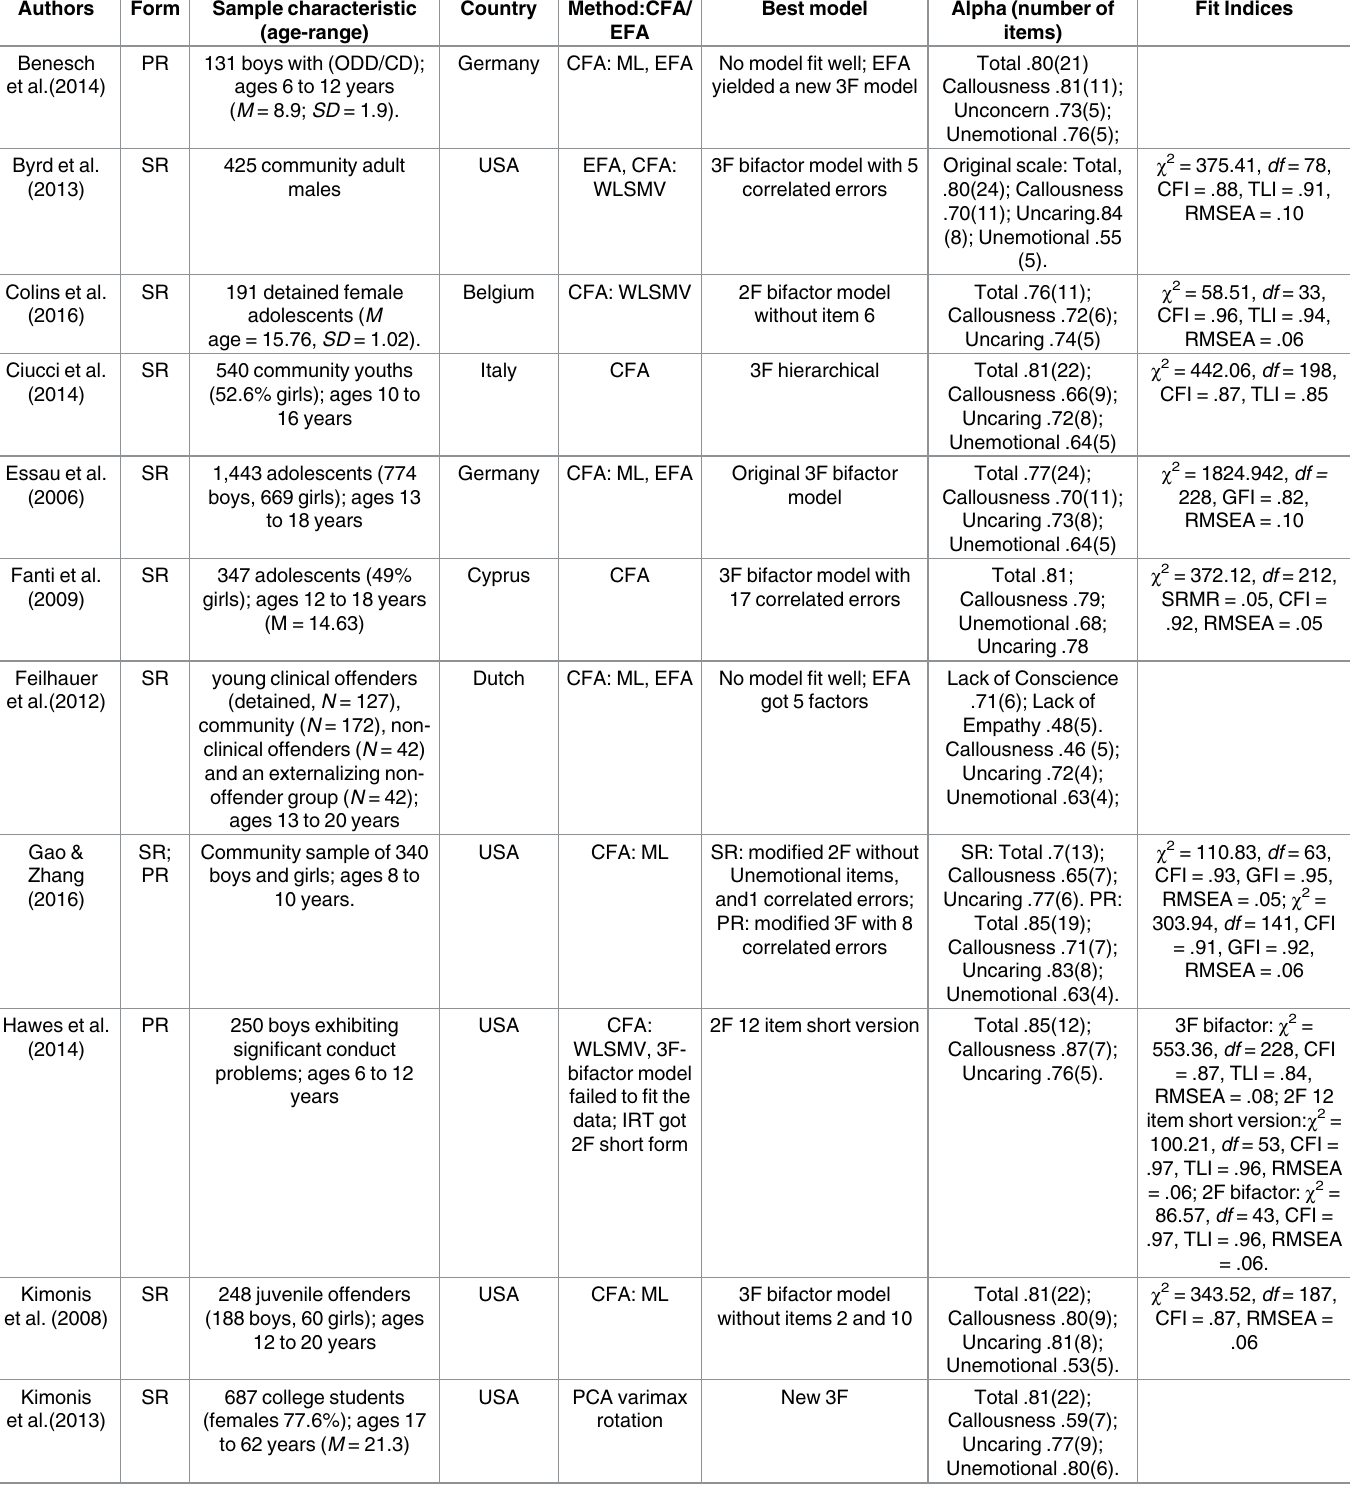
Table 1. Summaryof study characteristics and best fit models reported in previous CFA studies of